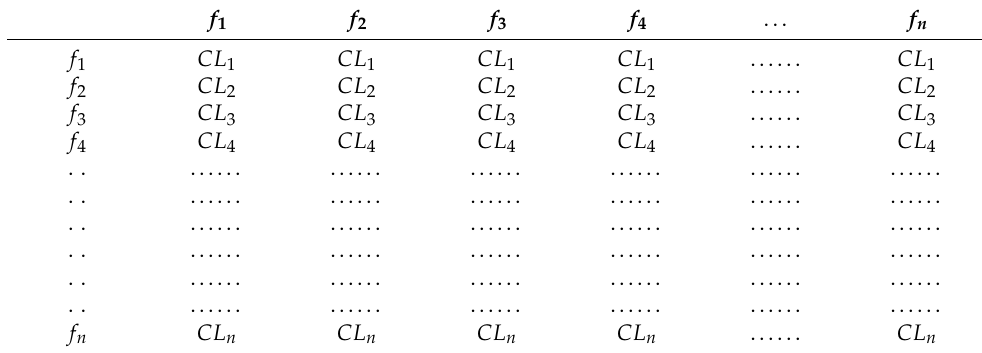
Table 3. Channelizing band based on femtocells